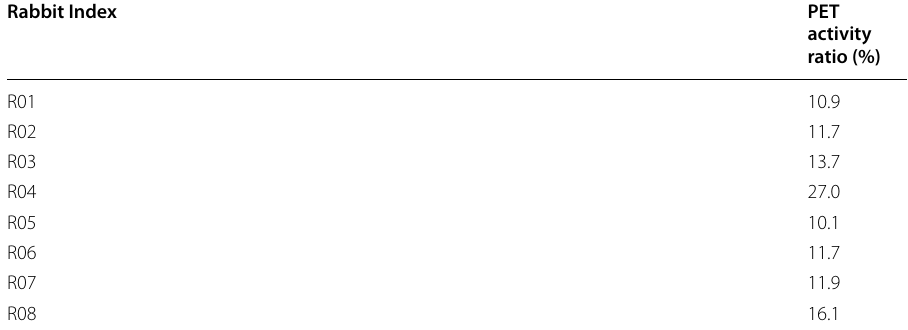
Table 2 Ratio of 90 Y activity outside of L shell to the activity within B to quantify extrahepatic 90 Y activity in the PET-based activity distribution A PET